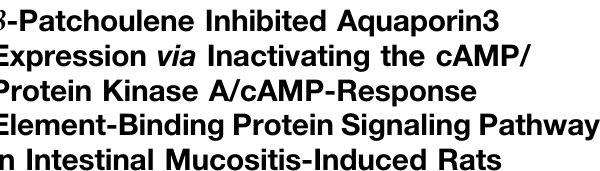
Frontiers in Pharmacology |